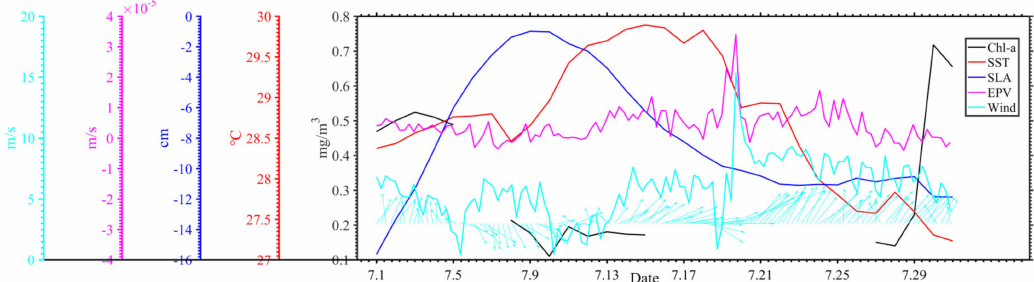
Figure 16. Time series of Chl- a concentration, sea surface temperature, sea level anomaly, Ekman pumping velocity, and wind speed (vector) in the coastal upwelling region–the eastern Leizhou